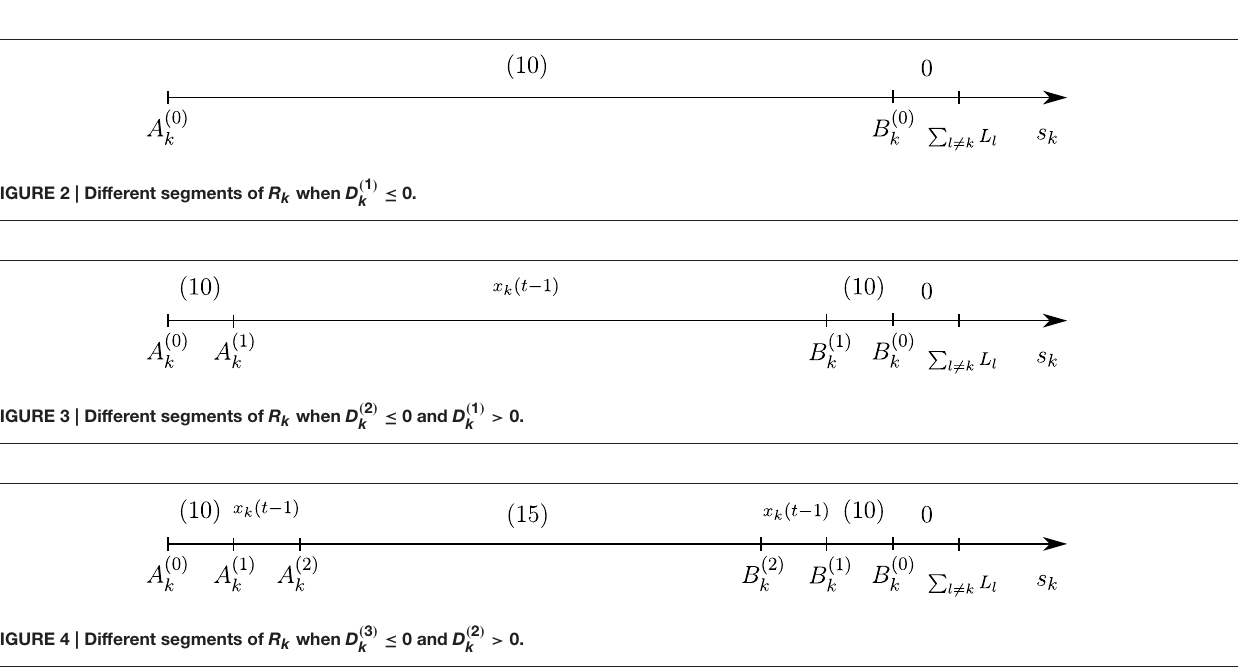
Frontiers in Applied Mathematics and Statistics |